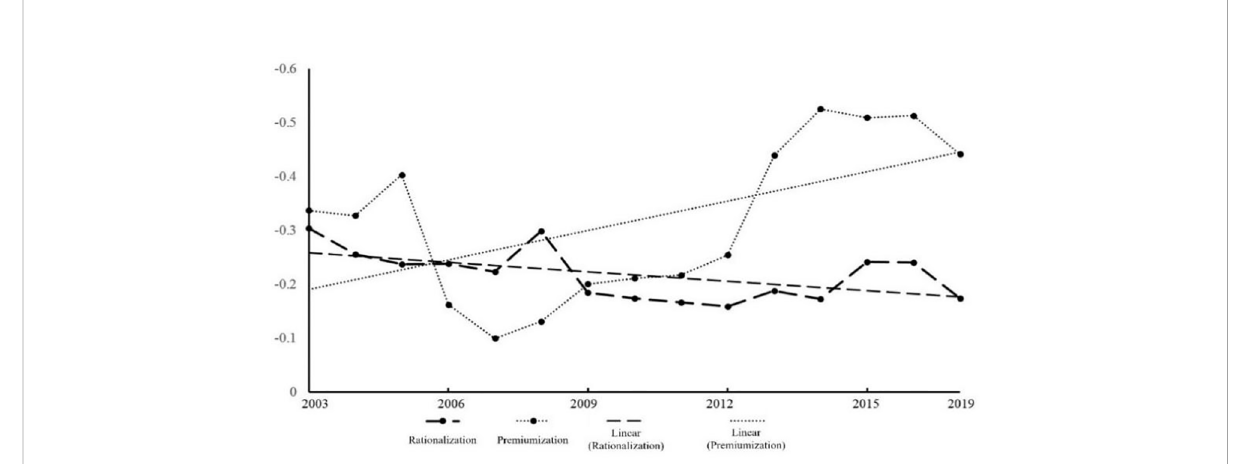
FIGURE 2 A correlation test of production restructuring in China ’ s marine fi shery